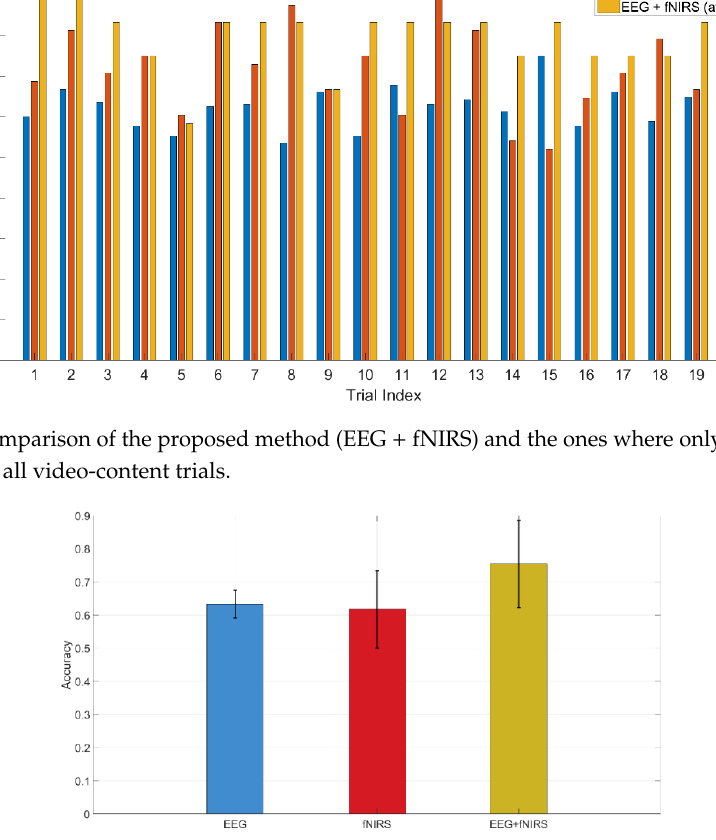
Figure 12. Performances of the proposed fNIRS + EEG method along with EEG only and fNIRS only techniques for all image-content trials as displayed. Whiskers are standard deviation.